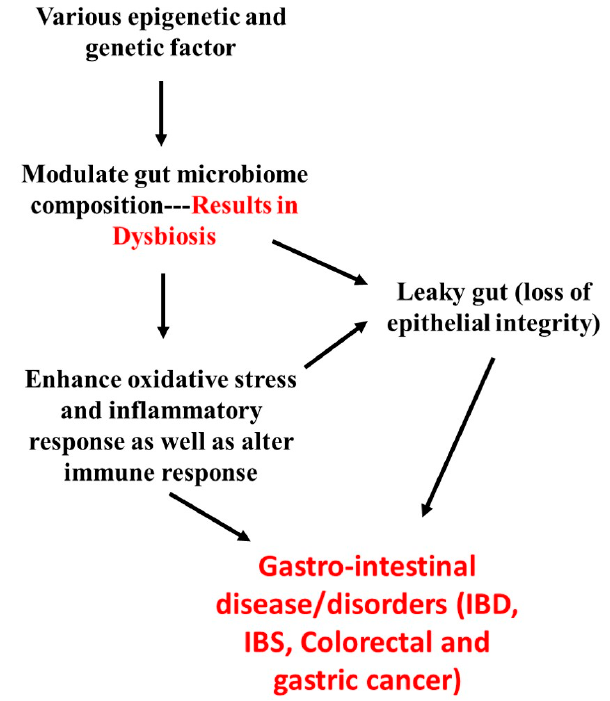
Figure 3. The overview of the pathophysiology of various gastrointestinal diseases and gut micro- biome. IBD—inflammatory bowel disease, IBS—irritable bowel